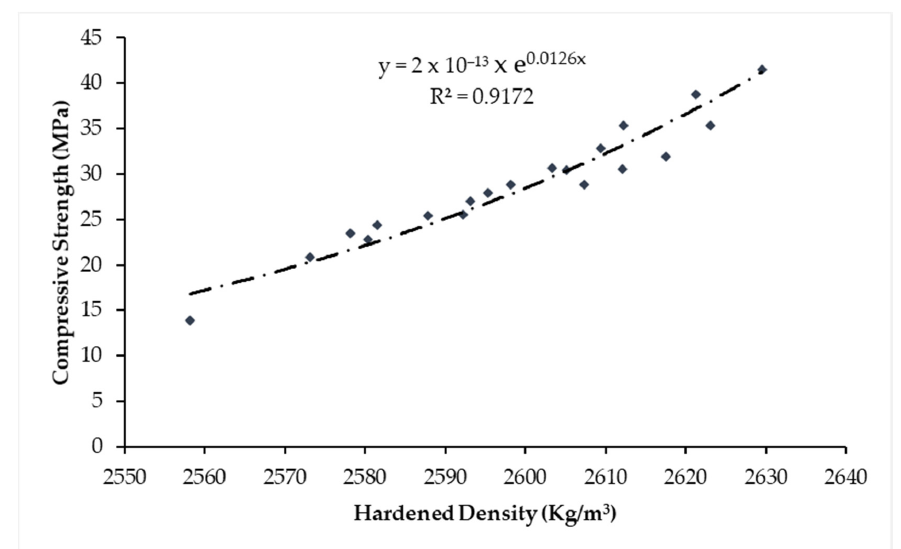
Figure 12. Regression relation between concrete hardened density and compressive strength.